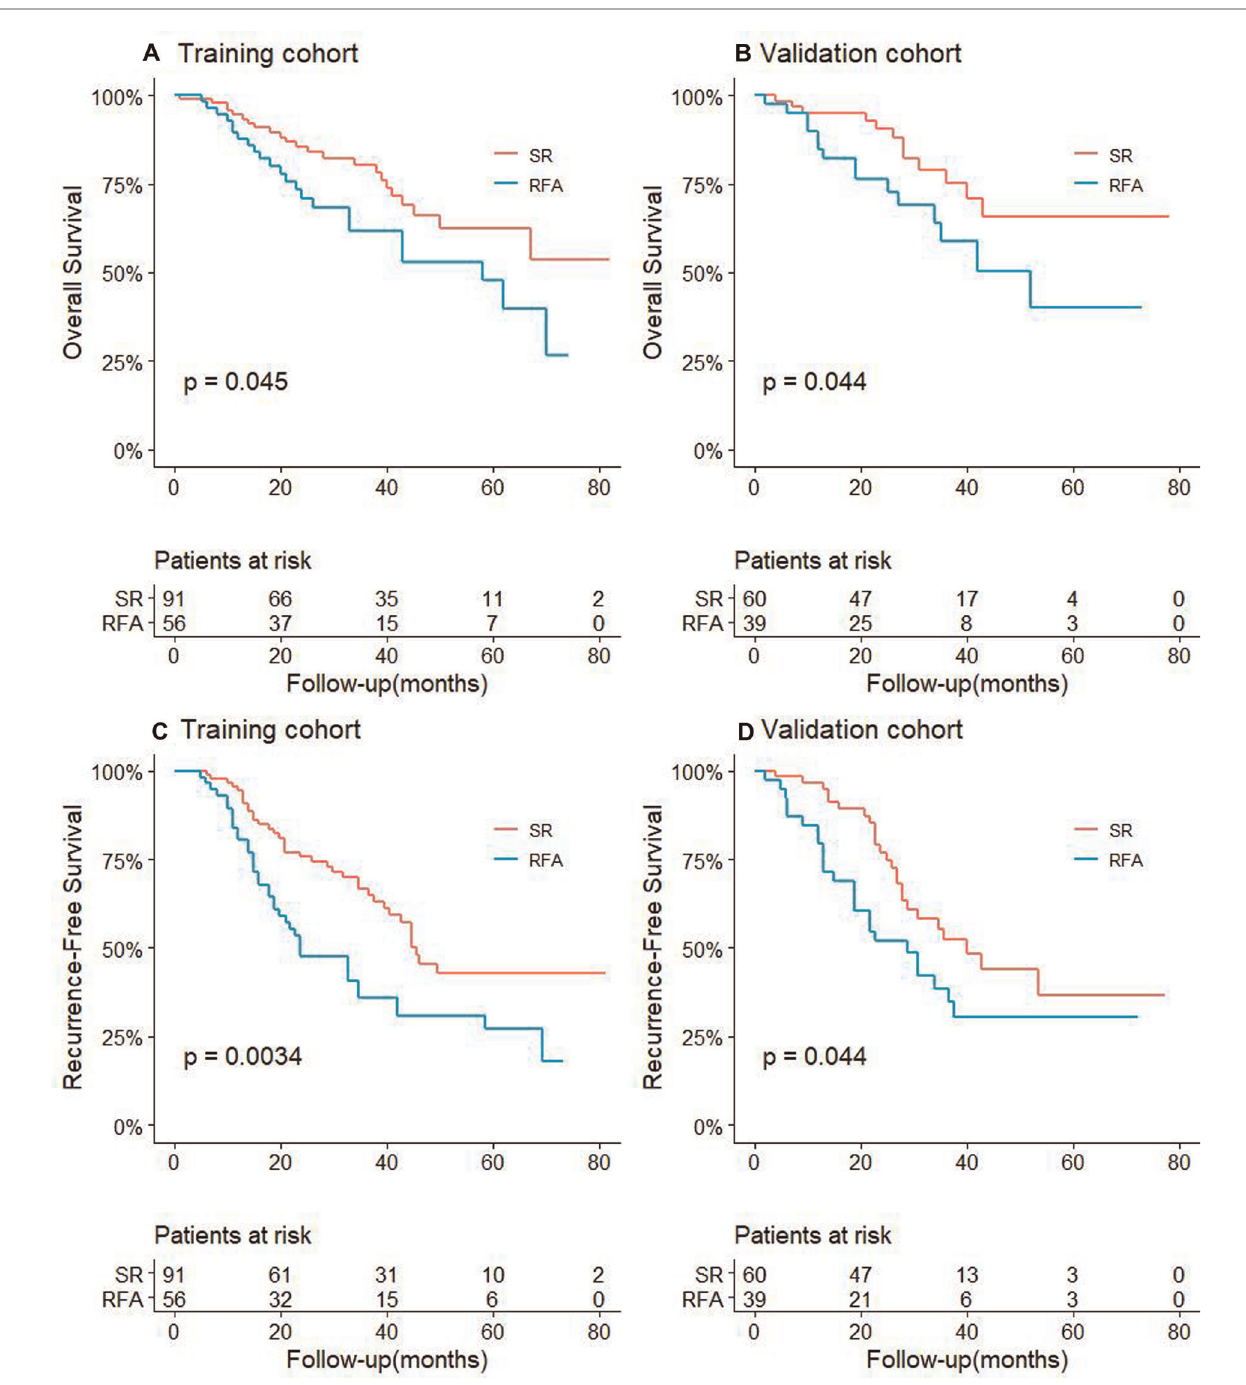
FIGURE 2 | Comparison of OS between RFA and SR groups in training cohort ( A ) and validation cohort ( B ) for patients with CTC-positive; RFS comparison between RFA and SR groups in training cohort ( C ) and validation cohort ( D ) for patients with